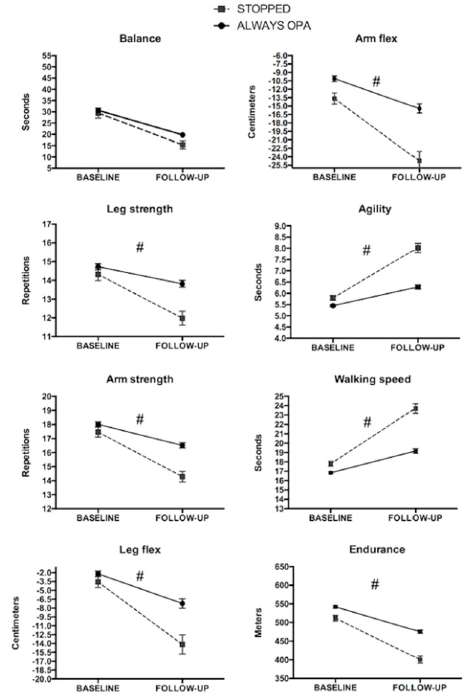
Figure 2. Fitness changes according to OPA engagement during the follow-up in females. # Significant group - by-time interaction. Both groups showed a significant decrease from baseline to follow-up ( p < 0.05).